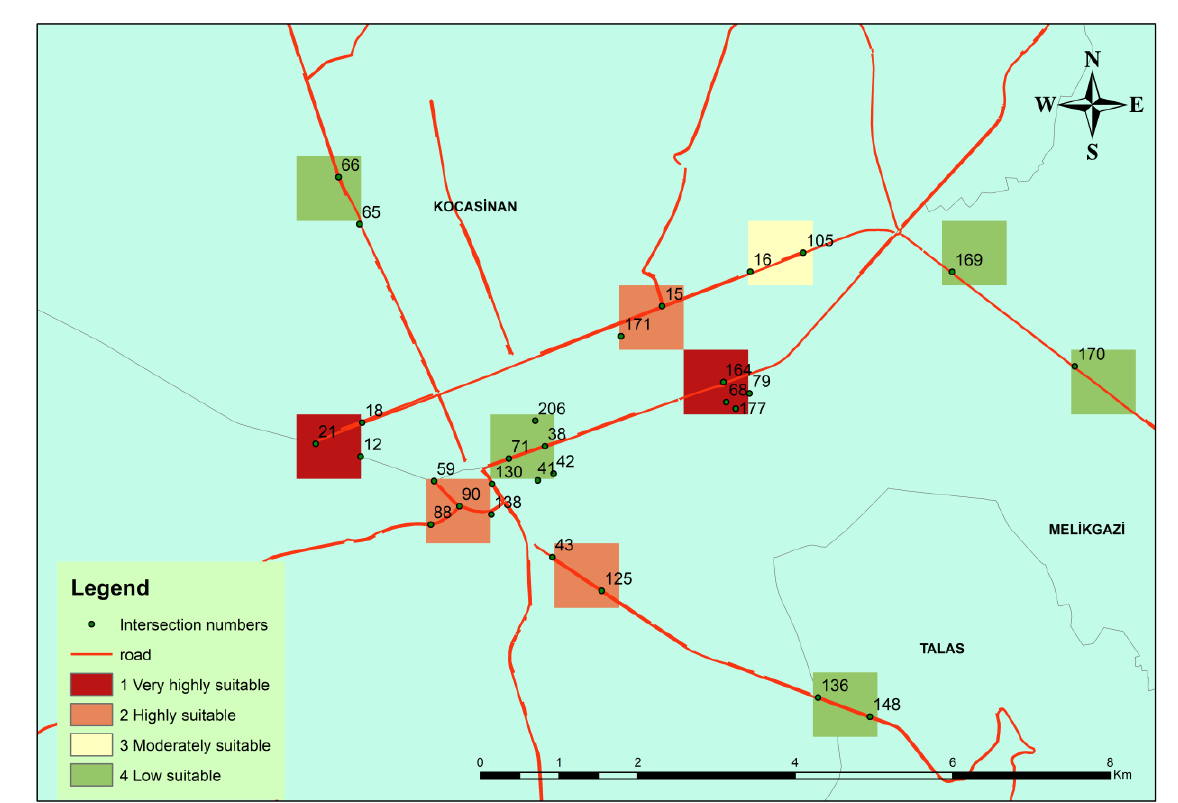
Figure 5. Smart intersection availability